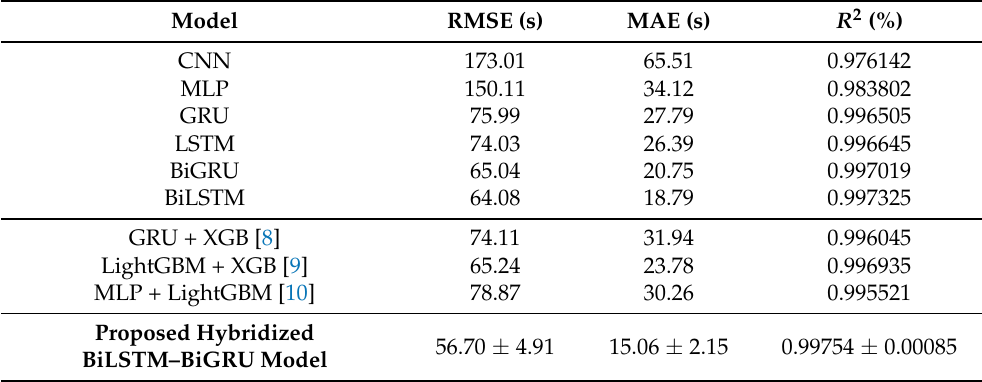
Table 6. The results from the experiment on the impact of omitting weekend data on